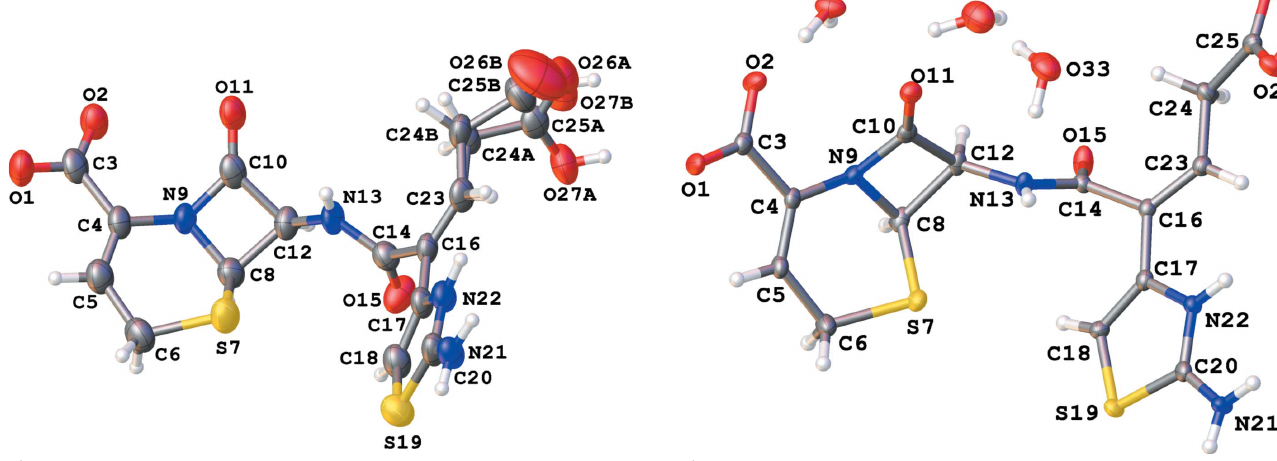
Figure 2 Molecular structure of (II). Ellipsoids of non-H elements are drawn at 50% probability.